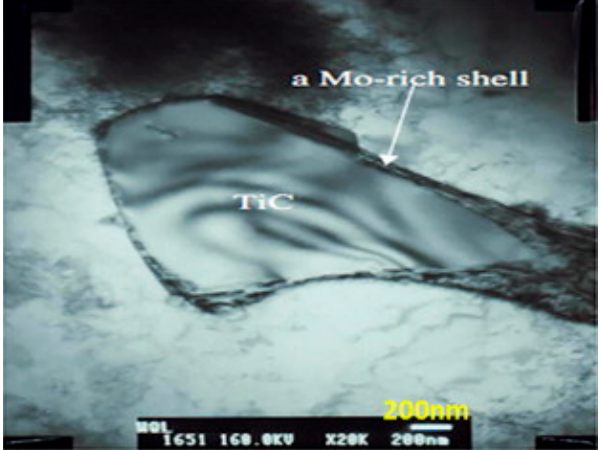
Figure 7. TEM bright field image showing a Mo-rich shell around TiC in Al-alloy (Al–0.6Cu–0.6 Mg–1.2Si–0.25Mn–10TiC–1Mo). Reprinted from Ref. [92] with permission from Chem. Eng. J.